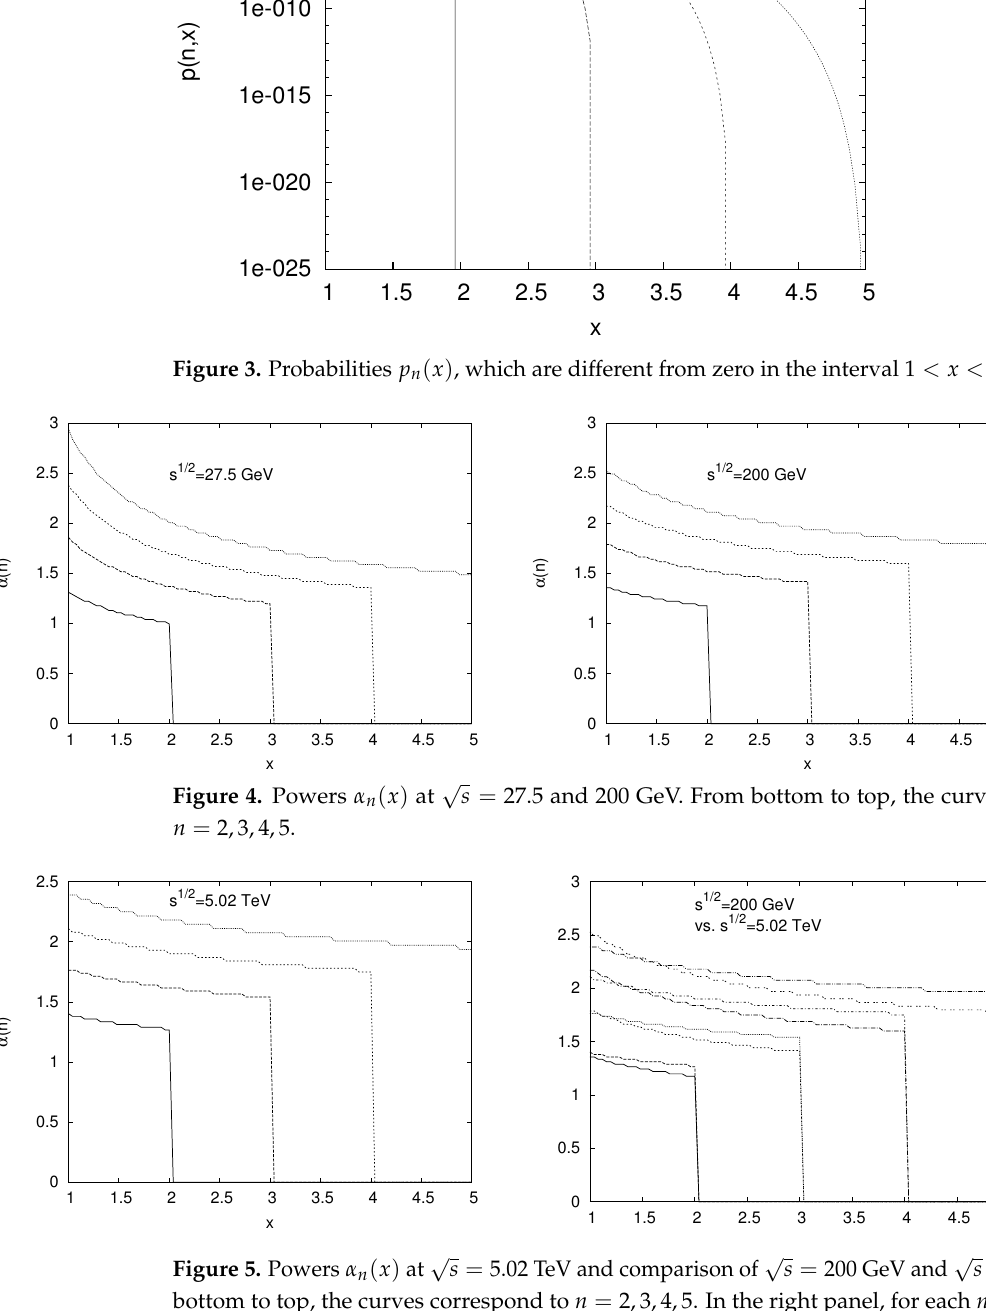
Figure 5. Powers α n ( x ) at bottom to top, the curves correspond to n = 2,3, 4,5. In the right panel, for each n the upper curve corresponds to the higher